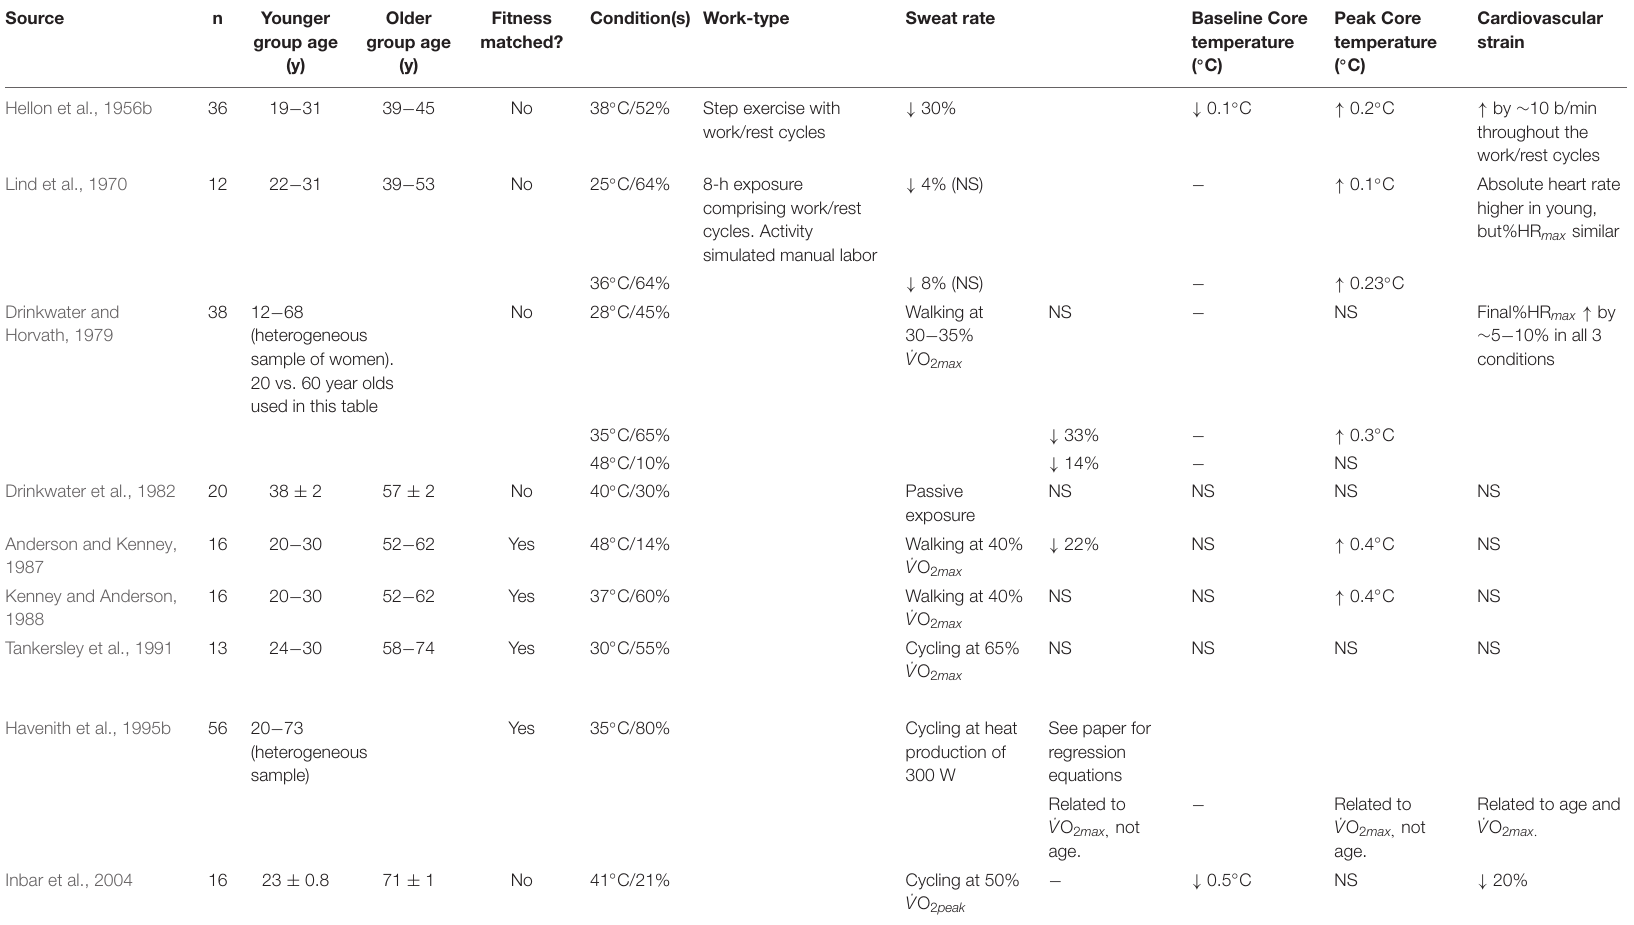
TABLE 7 | Overview of data relating to the effect of age on the heat stress response.